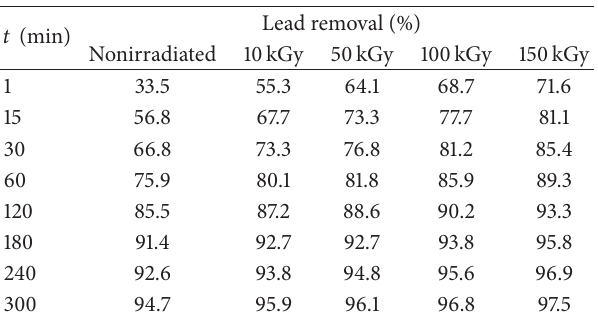
Table 3: Lead removal percentage of nonirradiated and irradiated minerals ( 𝐶 0 = 100 mg/L, 𝑇 = 20 ∘ C, 𝑤 = 1 g, and 𝑉 = 0.1